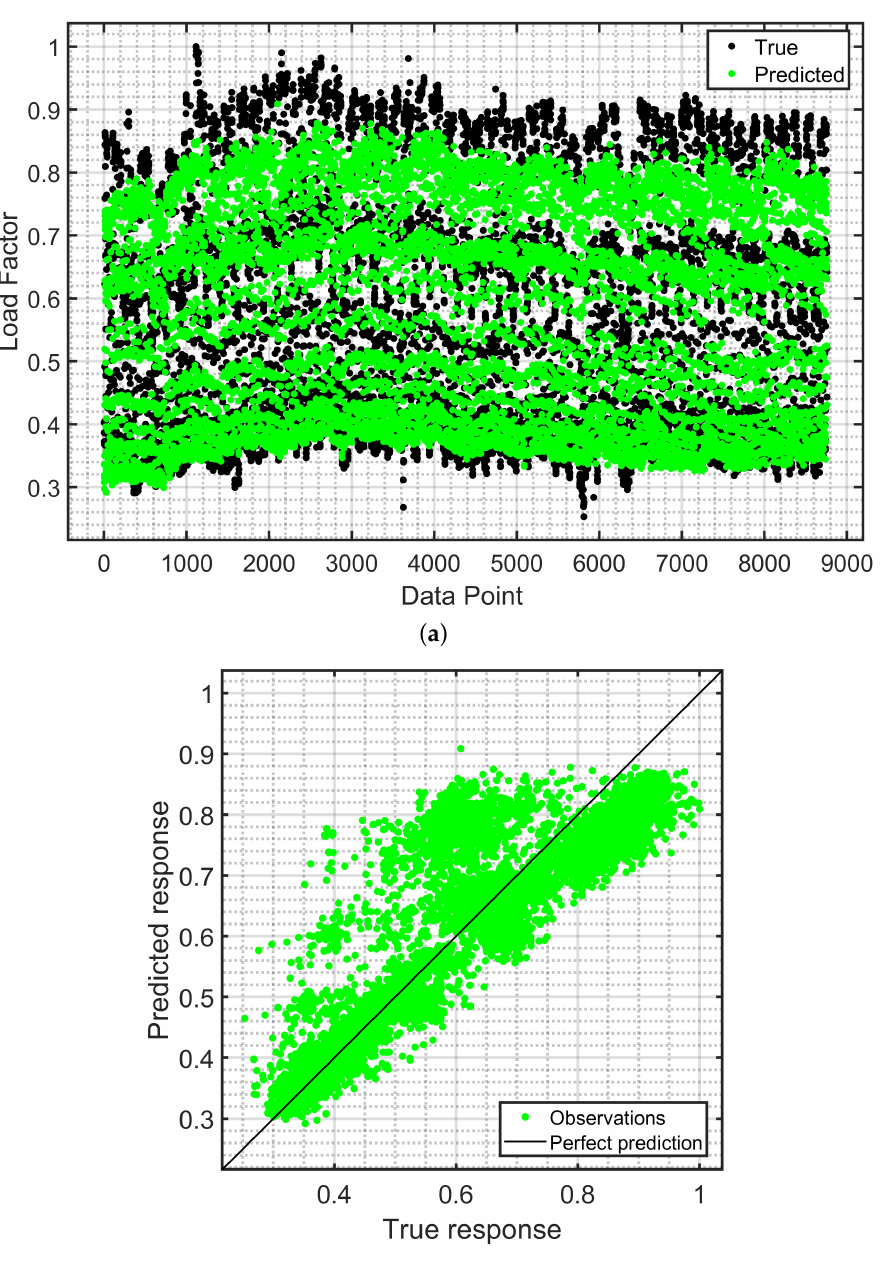
Figure 13. Results with Gaussian Process Regression. ( a ) Actual versus predicted values of Gaussian Process Regression. ( b ) Linearity analysis of Gaussian Process